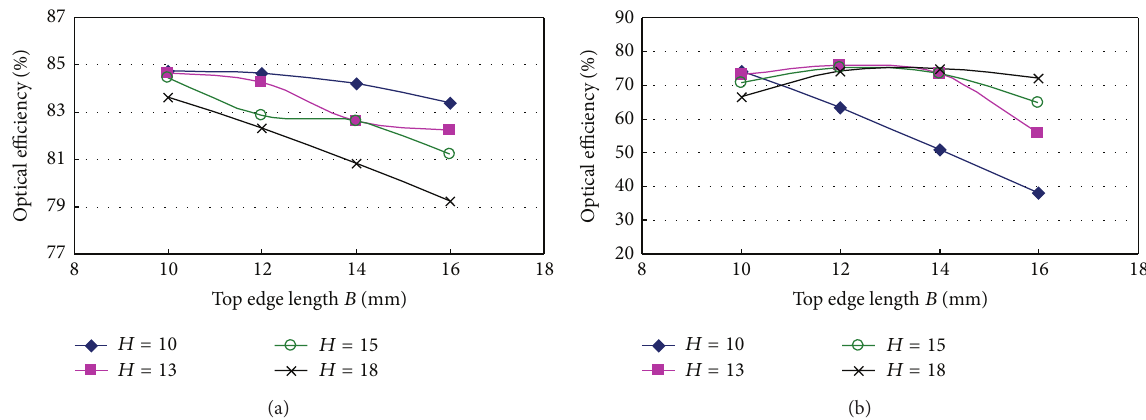
Figure 3: Effects of refractive pyramid SOE parameters on optical efficiency: (a) incidence angle = 0 ∘ (normal incidence) and (b) incidence angle = 1 ∘ .